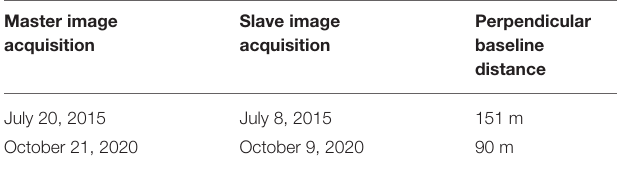
TABLE 1 | Summary of SAR image characteristics.